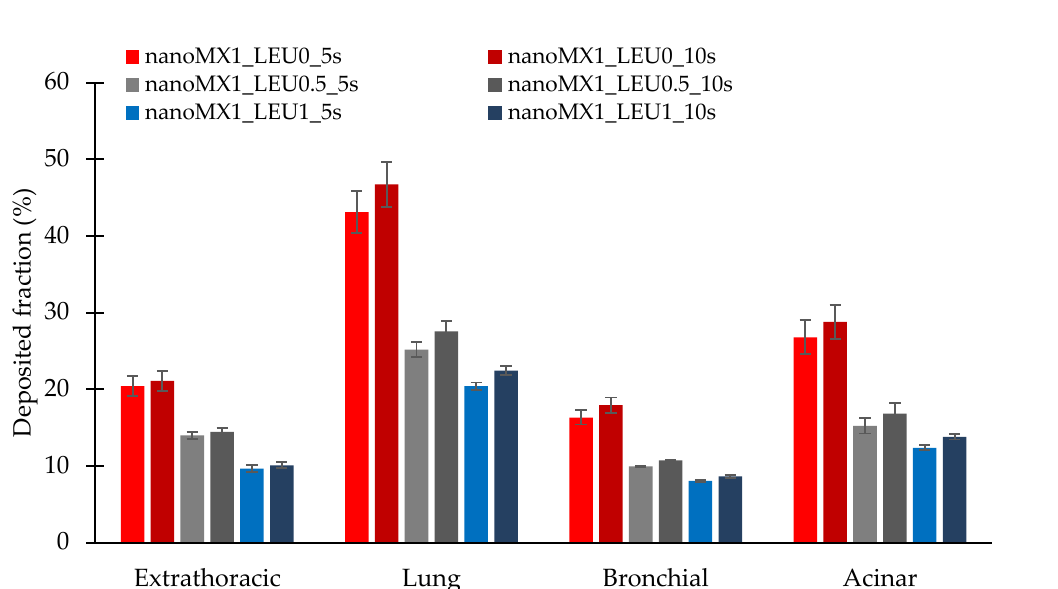
Figure 7. In silico aerodynamic results of the products (nanoMX1_LEU0, nanoMX1_LEU0_5s, nanoMX1_LEU0_10s, nanoMX1_LEU0.5_5s, nanoMX1_LEU0.5_10s, nanoMX1_LEU1_5s, and nanoMX1_LEU01_10s). Data are means ± SD (n = 3 independent measurements). Table 10. In silico aerodynamic properties with a breath-holding time of 10 s. Samples Deposited Fraction * (%) Extrathoracic